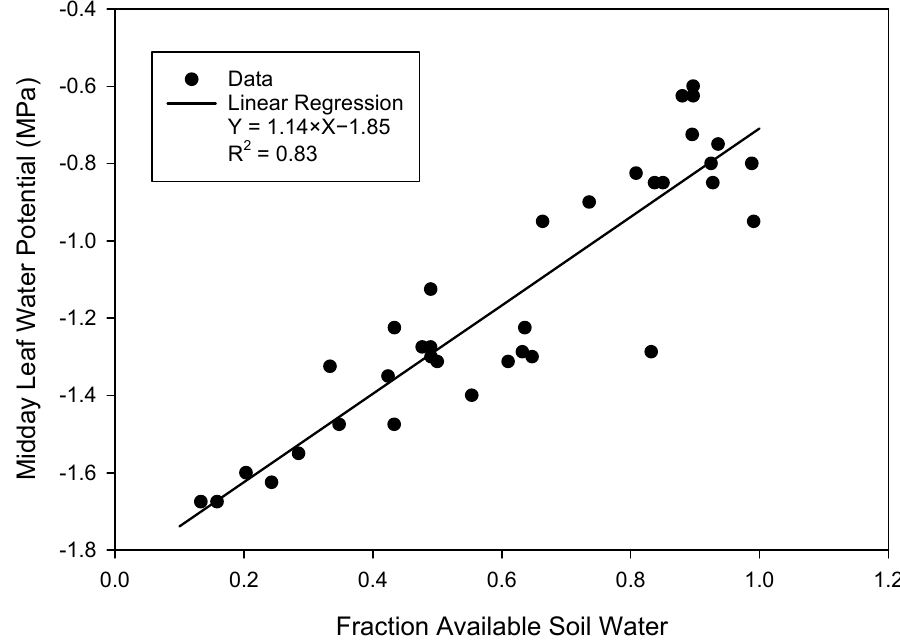
Figure 5. Relationship between the fraction available soil water and midday leaf water potential for Malbec in 2018.